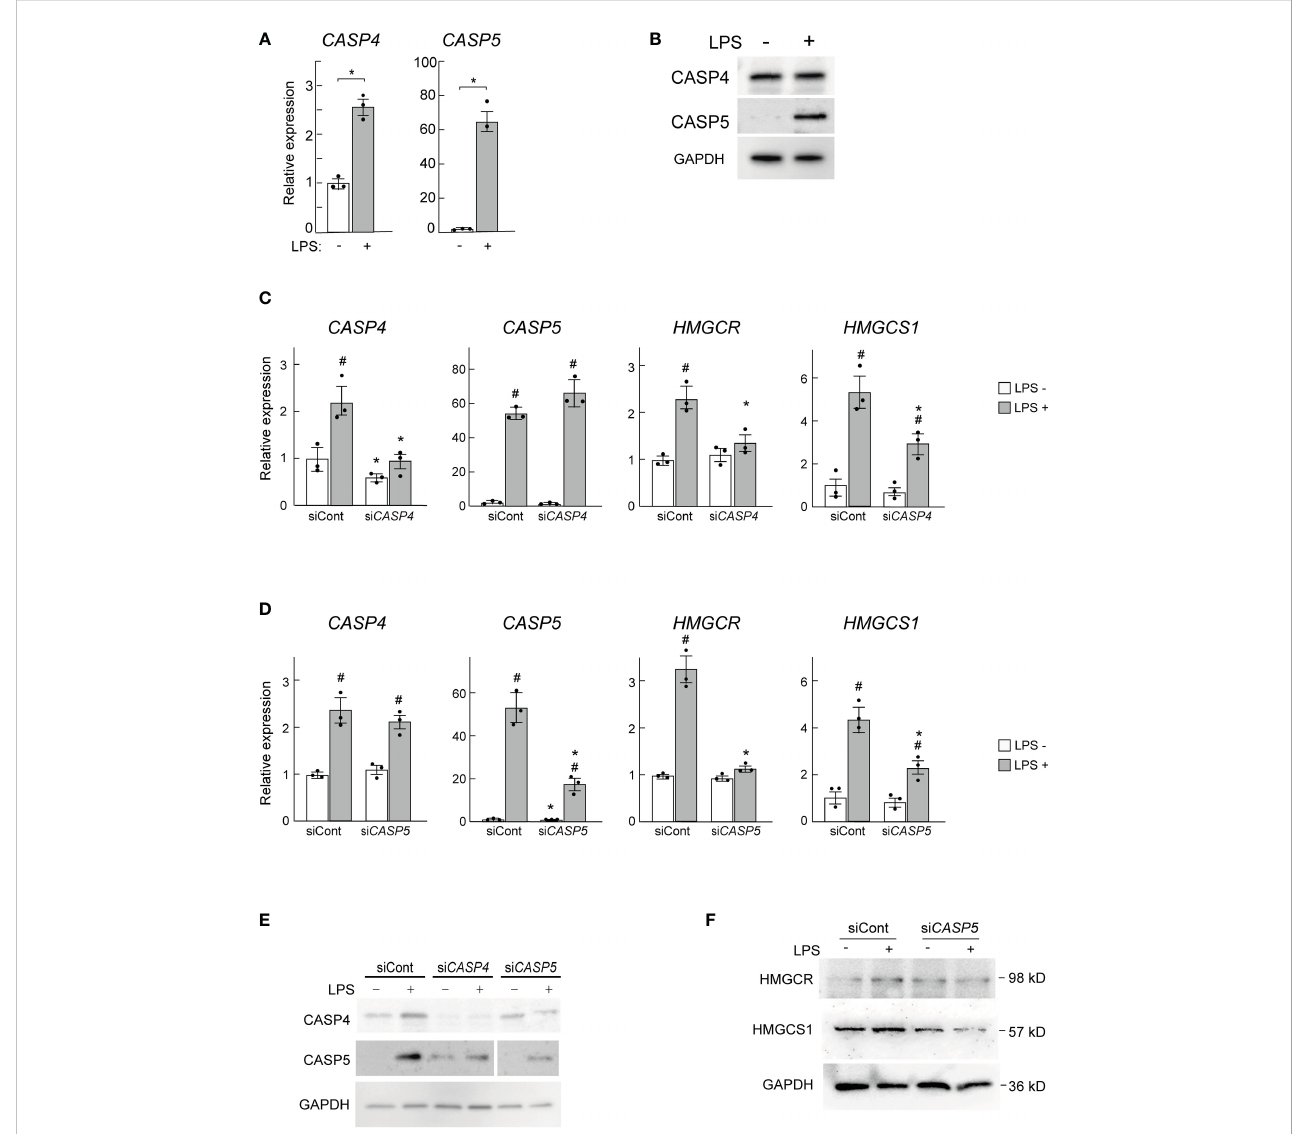
FIGURE 6 CASP5 deletion affects LPS-dependent gene expression in THP-1 cells. (A, B) THP-1 cells were stimulated with LPS (500 ng/ml) for 0 and 6h CASP4 and CASP5 mRNA expression levels were analyzed by qPCR (A) , and CASP4 and CASP5 protein expression levels were analyzed by western blotting (B) . (C, D) THP-1 macrophages were transfected with control siRNA (siCont) or siRNAs against CASP4 (C) or CASP5 (D) . The expression levels of CASP4 , CASP5, HMGCR , and HMGCS1 mRNAs in CASP4 (C) and CASP5 (D) knockdown cells were analyzed by qPCR. Signi fi cance was determined by one-way ANOVA followed by Tukey ’ s multiple comparison test. * P < 0.05 vs. the siCont-transfected cells without LPS, # P < 0.05 vs. the cells transfected with the same siRNA without LPS. (E) CASP4 and CASP5 protein levels in CASP4 and CASP5 knockdown cells were analyzed by western blotting. (F) HMGCR and HMGCS1 protein levels in CASP5 knockdown cells were analyzed by western